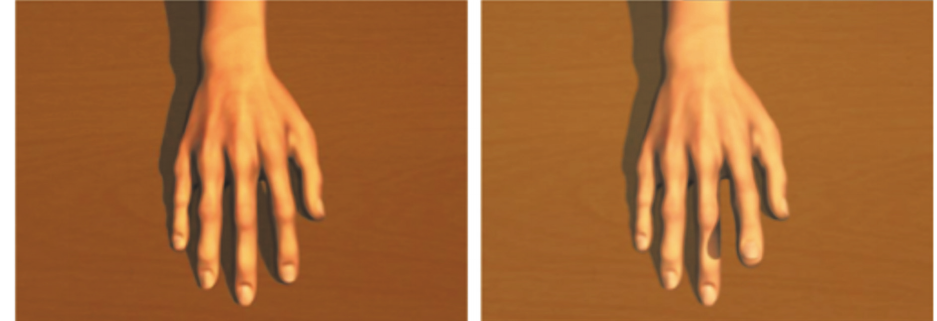
Figure 1: Right-hand third-person representation showing the hand at rest (left) and while performing an index lift movement